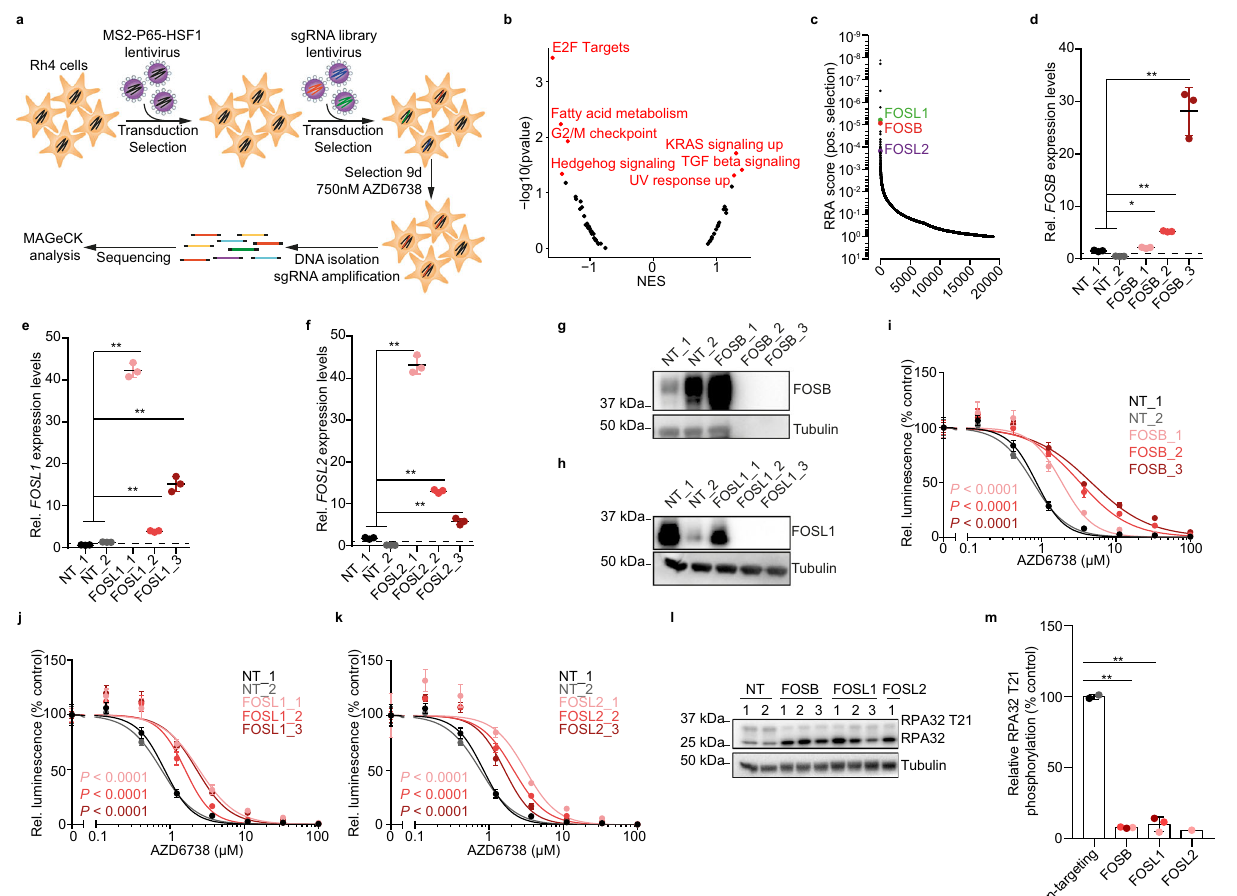
Fig. 5 | A genome wide CRISPR-based activation screen identi fi es molecular modi fi ers of sensitivity to ATR inhibition in PAX3-FOXO1-expressing ARMS cells. a Schematic representation of the genome wide CRISPRa screen experi- mental design. b Enrichment score for the GSEA hallmark pathways based on sgRNA enrichment. c Waterfall plot showing the positive robust rank aggregation (RRA)scoreofsgRNAsinRh4cellsincubatedinthepresenceofAZD6738for9days compared to DMSO treated cells as analyzed using MAGeCK. FOSB ( d , P =0.014; 5.45×10 − 6 ; 1.17×10 − 6 ), FOSL1 ( e , P =9.09×10 − 11 ; 5.16×10 − 6 ; 2.19×10 − 7 ) and FOSL2 ( f P =9.87×10 − 10 ;1.49×10 − 7 ;1.15×10 − 4 )mRNAexpressionmeasuredusingRT-qPCR in Rh30 cells expressing dCas9, lentiMPH and sgRNAs targeting FOSB , FOSL1 or